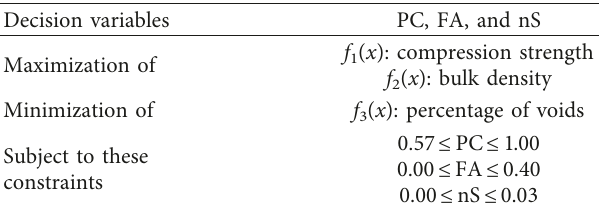
Table 3: Setup of the multiple criteria optimization